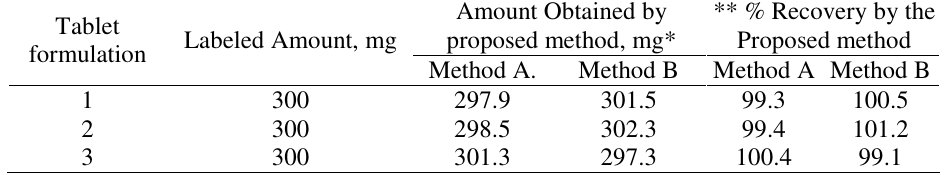
Table 1. Assay and recovery of abacavir sulphate in tablet dosage form.